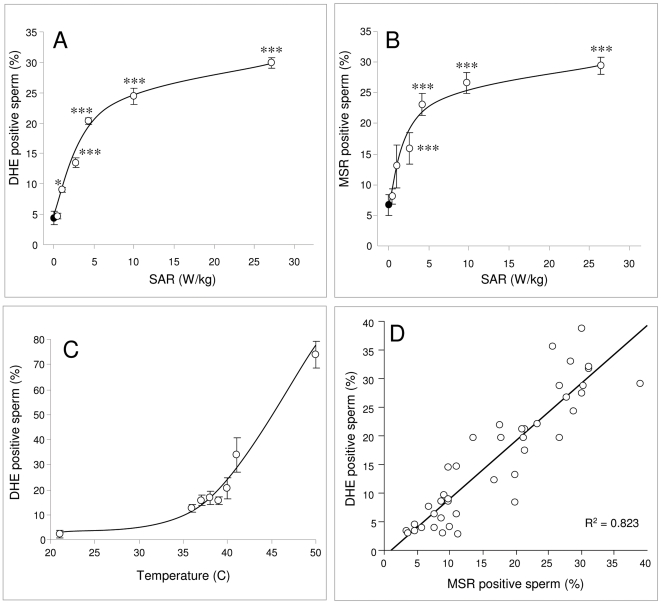
RF-EMR induces ROS generation in human spermatozoa, in an SAR-dependent manner unrelated to thermal effects.Percoll-purified spermatozoa (5×106 cells) were suspended in 1 ml BWW in a 35 mm Petri dish and placed within the waveguide while control cells placed outside the waveguide (closed circles). Cells in the waveguide were exposed to 1.8 GHz RF-EMR at SAR levels between 0.4 and 27.5 W/kg (open circles) for 16 h at 21°C. Also, purified sperm cells were subjected to incubation temperatures ranging from 21°C–50°C for 2 h. As the power levels were increased, the cellular generation of ROS increased in a dose-dependent manner. ROS levels were also observed to increase as a result of incubation temperature, but such results were not significant until the temperature exceeded 40°C. A, ROS generation (DHE response) was significantly increased from control levels after exposure to 1.0 W/kg (*p<0.05) and above (***p<0.001). B, RF-EMR induces ROS generation by the sperm mitochondria as monitored by MSR; significant increases were observed at SAR values of 2.8 W/kg (***p<0.001) and above. All results are based on 4 independent samples. C, In order to control for thermal effects, the impact of temperature of cellular ROS generation was monitored; a significant increase in ROS generation was observed as temperatures rose above 40°C (p<0.001). D, Across the entire data set, the total level of ROS generation by human spermatozoa (DHE positive cells) was highly correlated with the level of ROS generation by the mitochondria (MSR positive cells: R2 = 0.823).